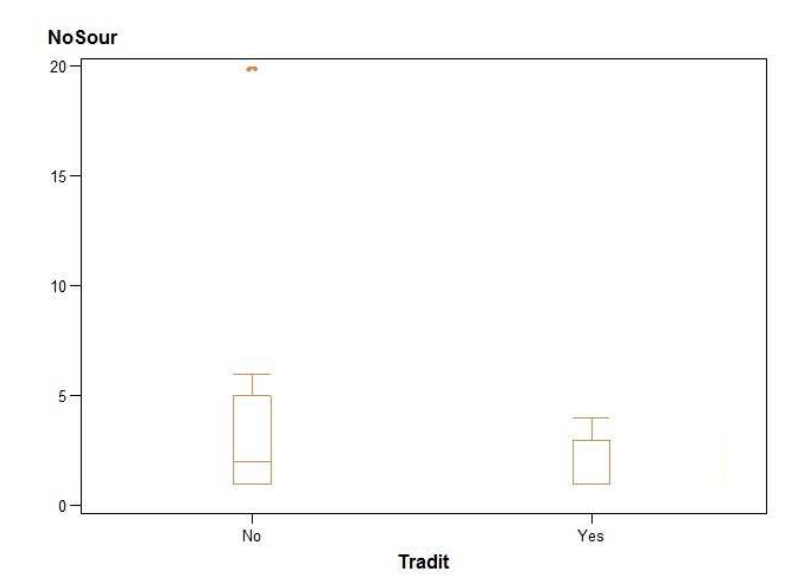
Figure 4 – Box-plot of number of funding sources in Traditional and other